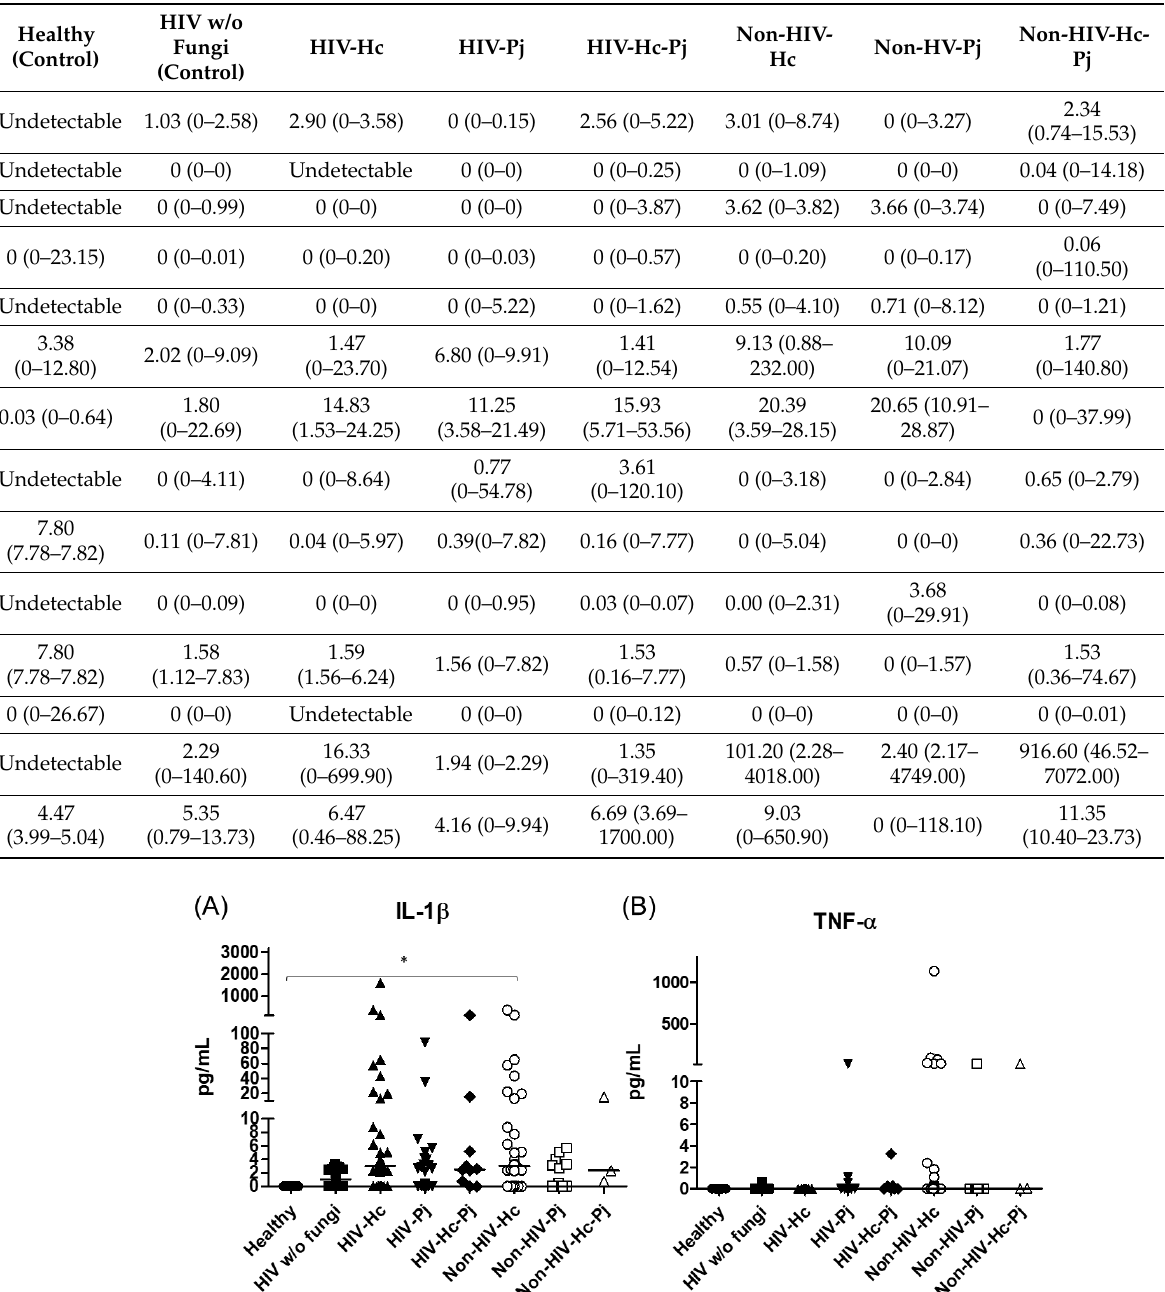
Figure 3. IL-1 β and TNF- α proinflammatory cytokines determination. These cytokines were detected by a cytometric bead assay in the BAL samples of hospitalized patients; results were obtained in pg/mL. Median values are shown for ( A ) IL-1β and ( B ) TNF-α. * p < 0.05.